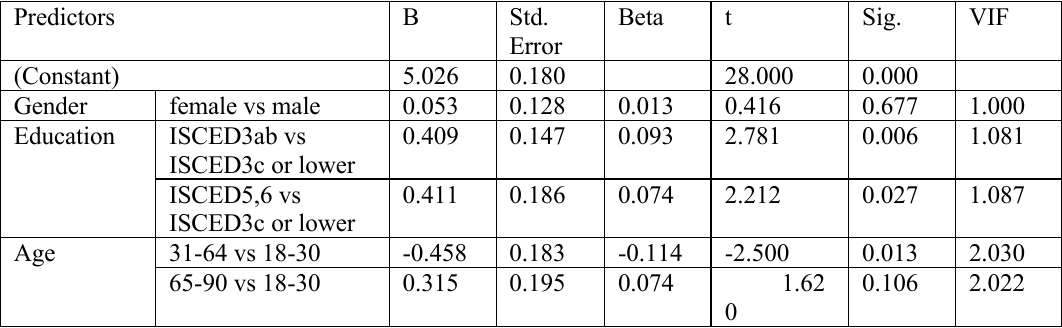
Table 4: A model for extrinsic motivation Predictors